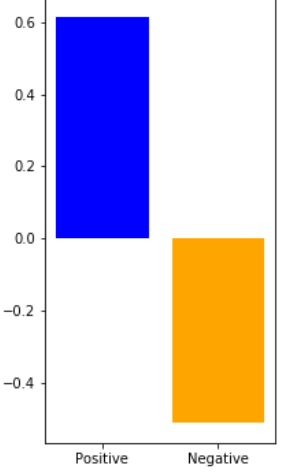
Figure 5. Facebook news sentiments.